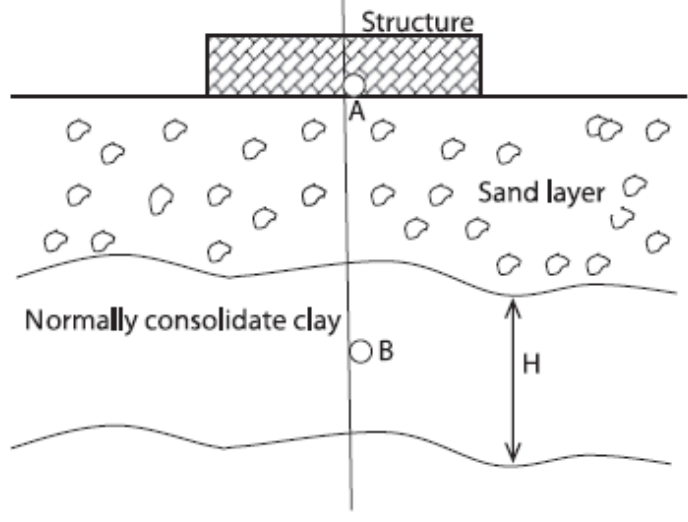
Figure 4. The model of soil settlement. Table 3. Random variables in Example 2.